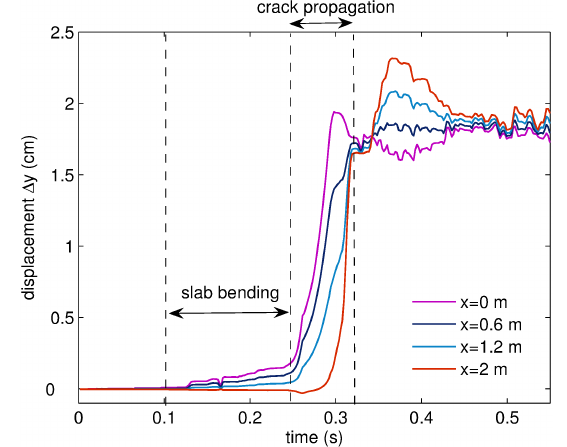
Figure 8. Temporal evolution of the modeled vertical displacement (cid:49)y of the slab for a slab density ρ = 250kgm − 3 .The different curves correspond to different horizontal positions of the slab, from the left-end ( x = 0m) to the right-end ( x = 2m).